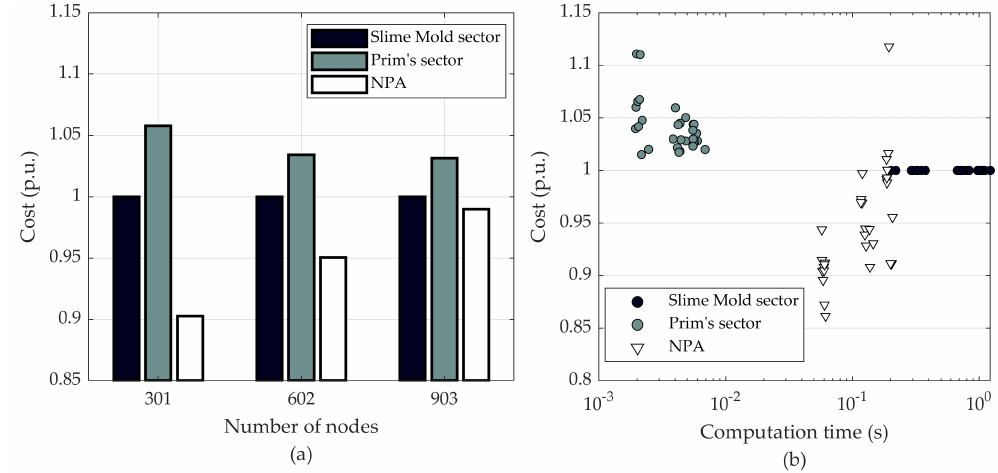
Figure 8. Average cost of urban networks ( a ), and the cost and the computation time of each network ( b